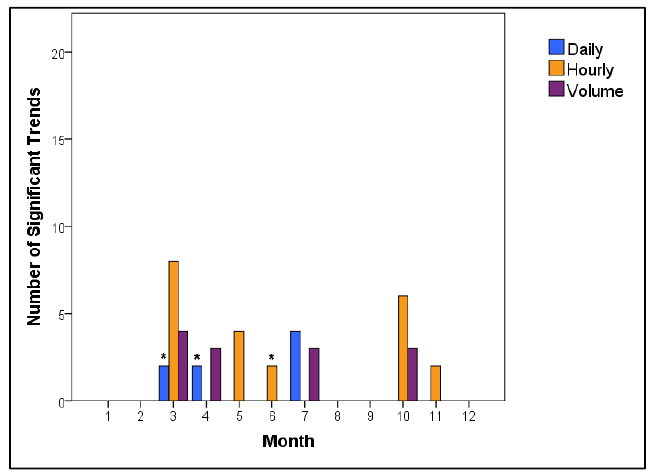
Figure 4. The number of significant trends for months meeting field significance thresholds at 5%. * indicates spatial autocorrelation detected for month and scale.